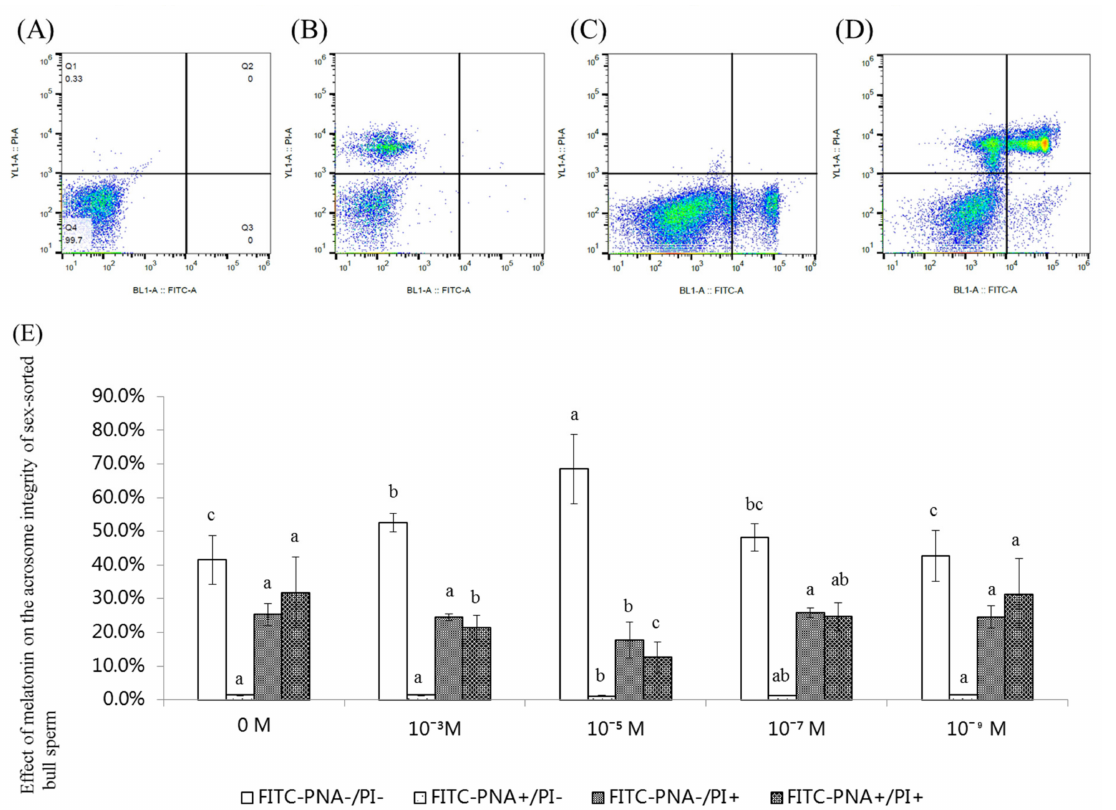
Figure 5. E ff ect of melatonin on the acrosome integrity of sex-sorted bull sperm. ( A ) Negative control. ( B ) PI staining. ( C ) FITC-PNA staining. ( D ) FITC-PNA / PI staining. Acrosome staining of sex-sorted sperm of bull. Quadrants represented viable sperm with integral acrosome (lower-left quadrant), viable sperm with damaged acrosome (lower-right quadrant), dead sperm with integral acrosome (upper-left quadrant), and dead sperm with damaged acrosomes (upper-right quadrant). ( E ) E ff ect of melatonin on the acrosome integrity of sex-sorted bull sperm. Lowercase letters represent statistical significant di ff erence ( p <